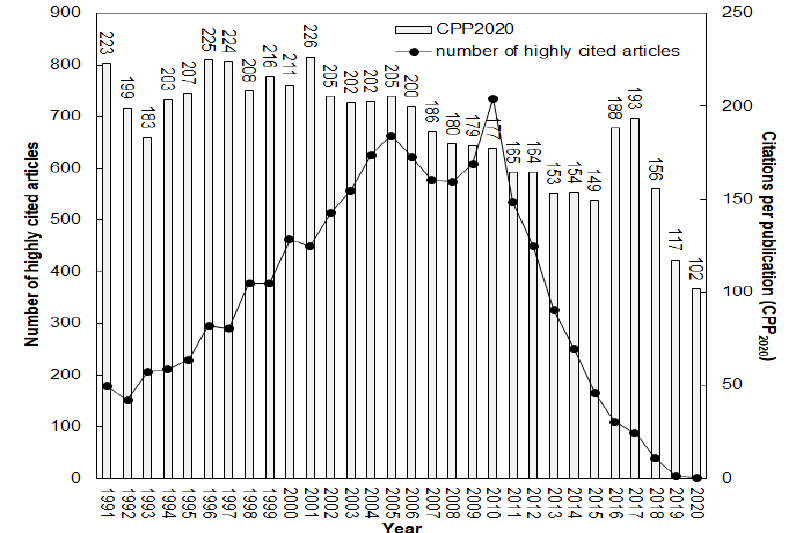
Fig. 1. Number of highly cited articles and citations per publication by year